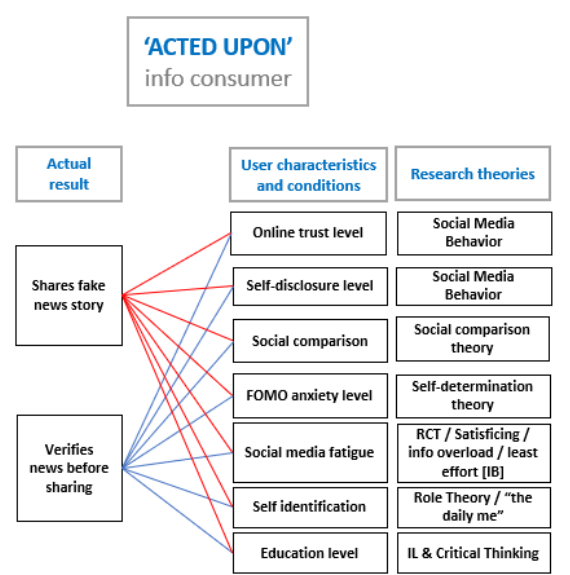
Figure 3. Detail of fake news model showing the ‘acted upon,’ or information consumer side of the duality, including Talwar’s five characteristics and two new ones (self-identification/roles and education level), along with research theories and results. Available at this url: http://scholarworks.csun.edu/handle/10211.3/218953, accessed on 6 July 2021. [License: Attribution-ShareAlike 4.0 International (CC BY-SA 4.0)].